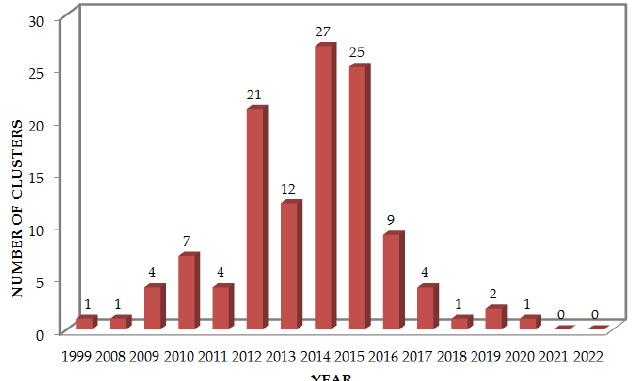
Figure 3. The number of clusters formed annually in Russia in 1999–2022 accounting for data provided by HSE. Table 2. Distribution of regions in Russia with clusters; the data have been adapted from Refs. [26,100]. No Region Number of Clusters RRII Rating Number of Employees